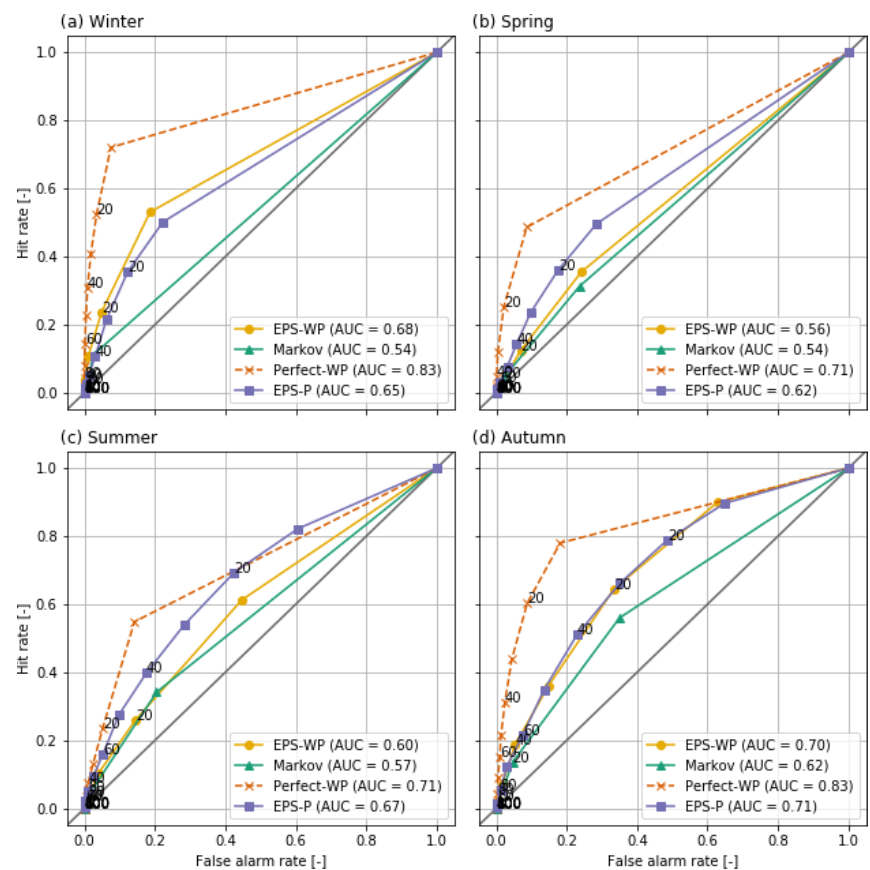
Figure 9. As Fig. 8 but for moderate